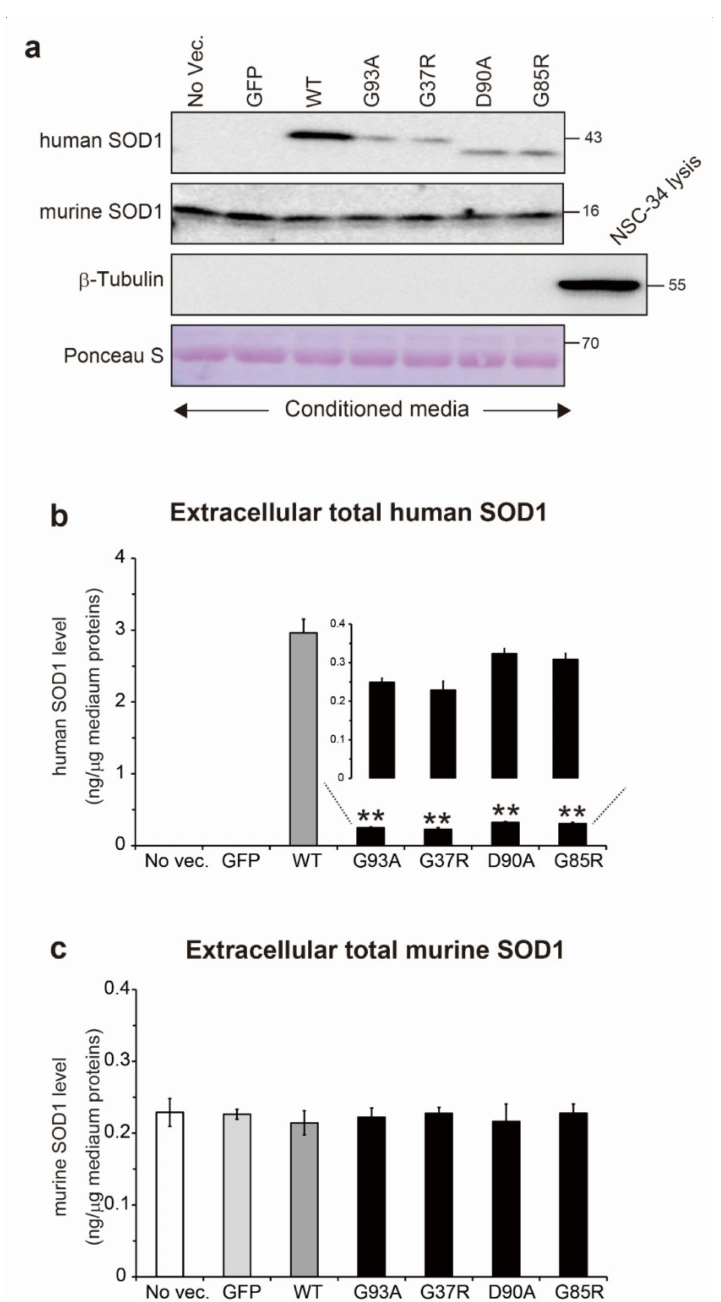
Figure 2. Decrease in the total level of extracellular hSOD1 mutants, but not murine SOD1, in the conditioned medium. The NSC-34 cells were transiently transfected with human wild-type superoxide dismutase 1 (hSOD1 WT ) and the ALS-causing hSOD1 mutants (G93A, G37R, D90A, and G85R) fused with green fluorescent protein (GFP). After 72 h of transfection, the conditioned medium from the cells was collected; ( a ) Western blots of hSOD1-GFP and endogenous murine SOD1 in the medium, β -tubulin was used as a marker for intracellular non-secreted protein to confirm whether cell lysis or debris could be contaminated in the conditioned medium. The amount of protein loaded for sodium dodecyl sulfate polyacrylamide gel electrophoresis was validated by Ponceau S staining; ( b , c ) quantification of the absolute total protein level of extracellular ( b ) hSOD1 and ( c ) murine SOD1. Data are shown as the mean ± SD, n = 3 in each transfection. Statistical analysis was performed using one-way ANOVA followed by the Tukey–Kramer post hoc test. ** p < 0.01 vs. hSOD1 WT